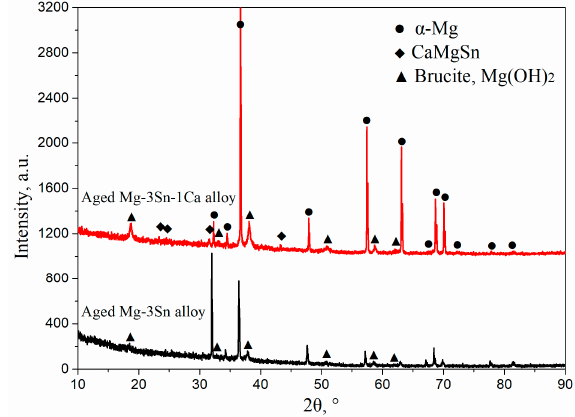
Figure 9. XRD patterns of aged Mg-3Sn and Mg-3Sn-1Ca alloys for 7 h at 513 K after immersion in 3.5 wt.% NaCl solution for 12 h.